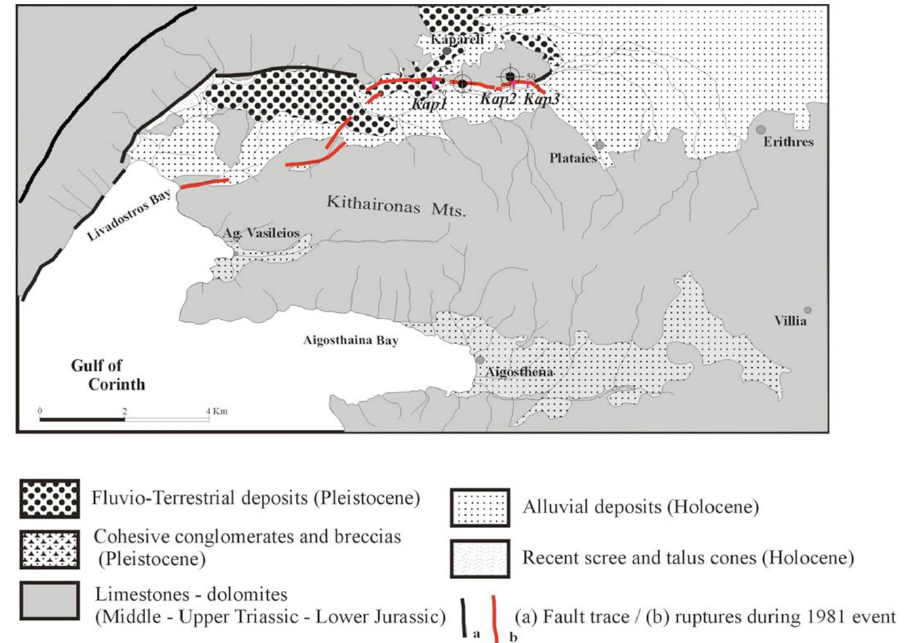
Figure 2. Geological map of the Kaparelli area in central Greece. The 1981 ruptures are shown in red. Kap1, Kap2 and Kap3 denote trench- ing sites. Map after Kokkalas et al. [2007] and Ganas et al.